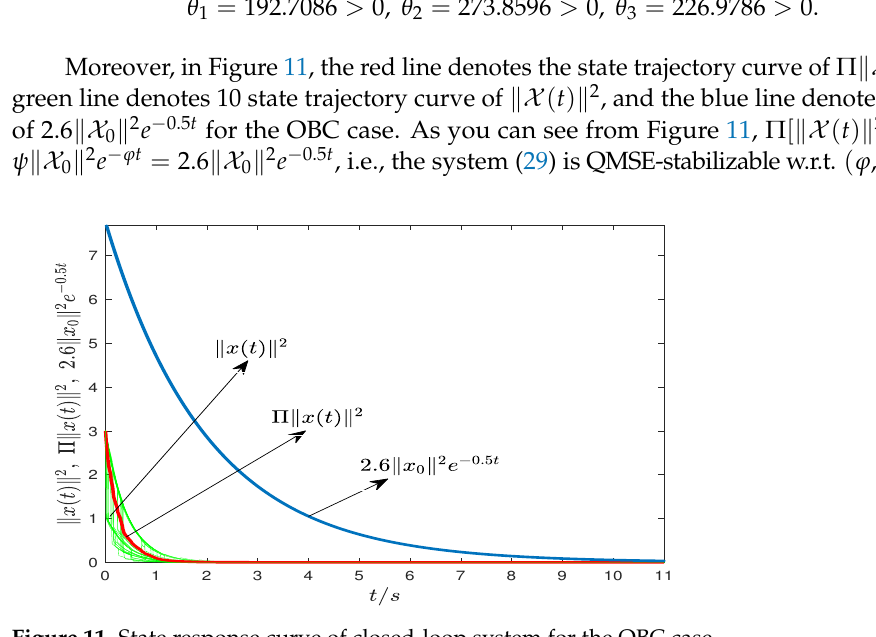
Figure 11. State response curve of closed-loop system for the OBC